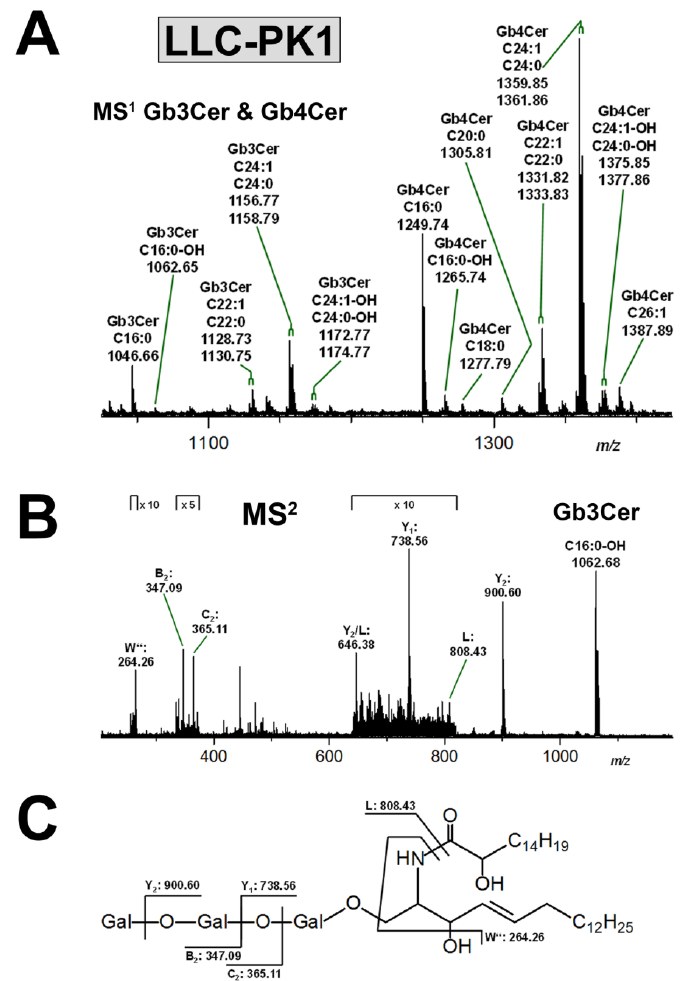
Figure 3. Overview mass spectrometry (MS) 1 spectrum of the Stx receptor GSLs Gb3Cer and Gb4Cer ( A ) and MS 2 spectrum of selected Gb3Cer (d18:1, C16:0-OH) species ( B ) with the auxiliary fragmentation scheme ( C ) obtained from porcine LLC-PK1 kidney epithelial cells. The MS 1 spectrum